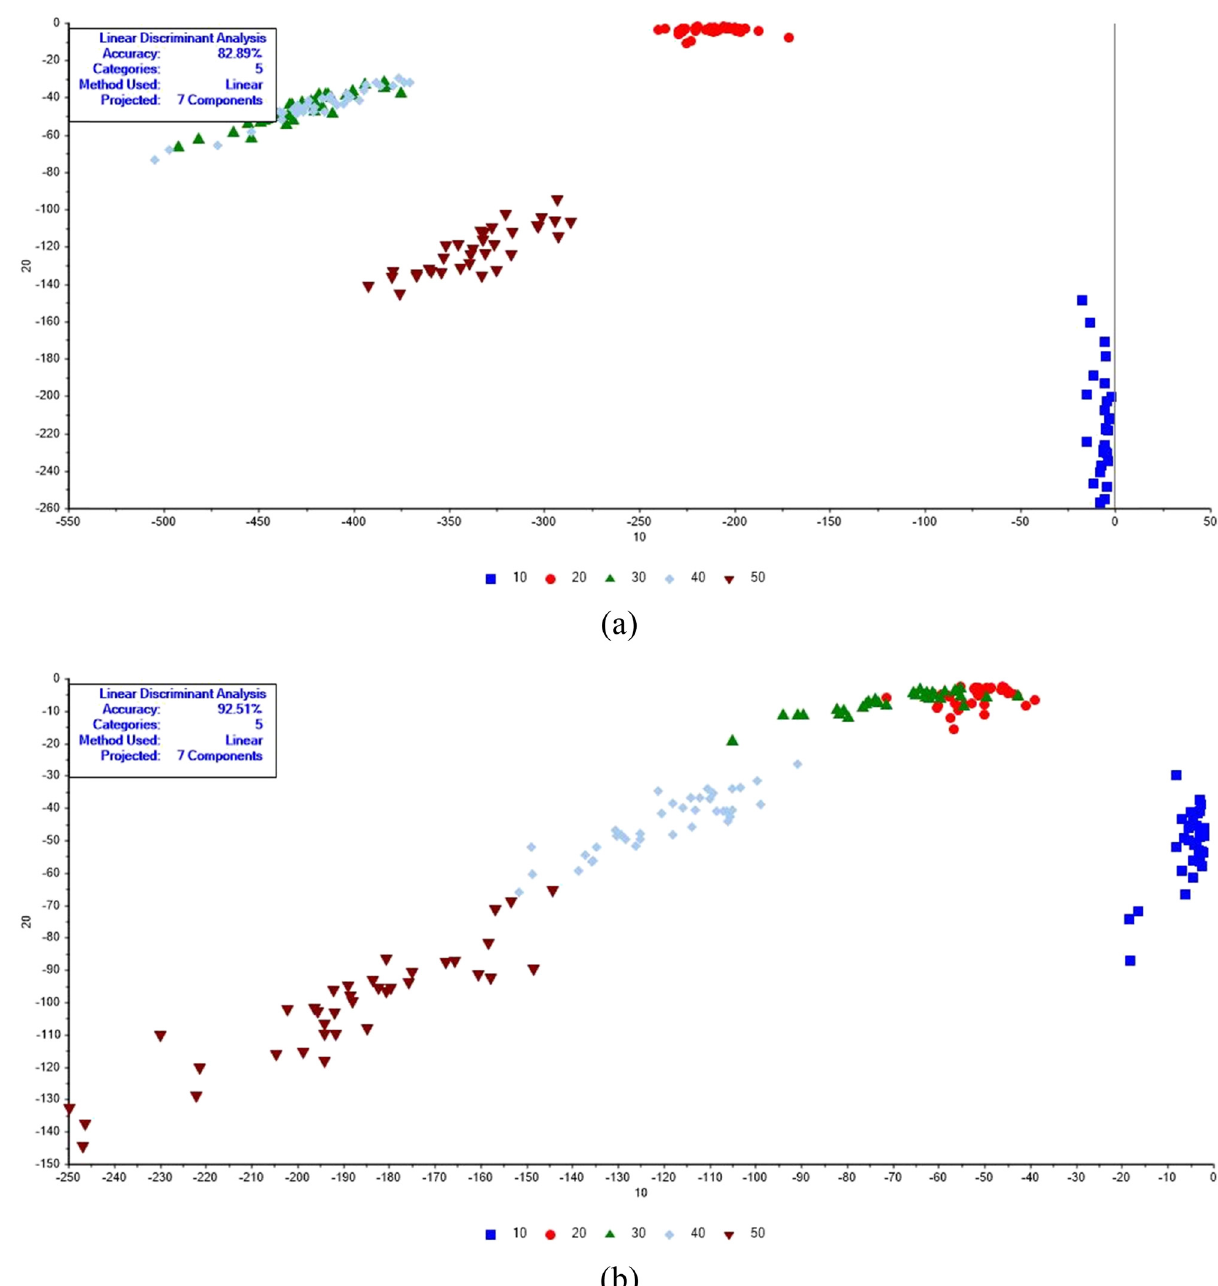
Figure 6: PCA - DA classi fi cation plots of butter fl y - pea extract powder with various levels of: ( a ) maltodextrin; ( b ) SPI.